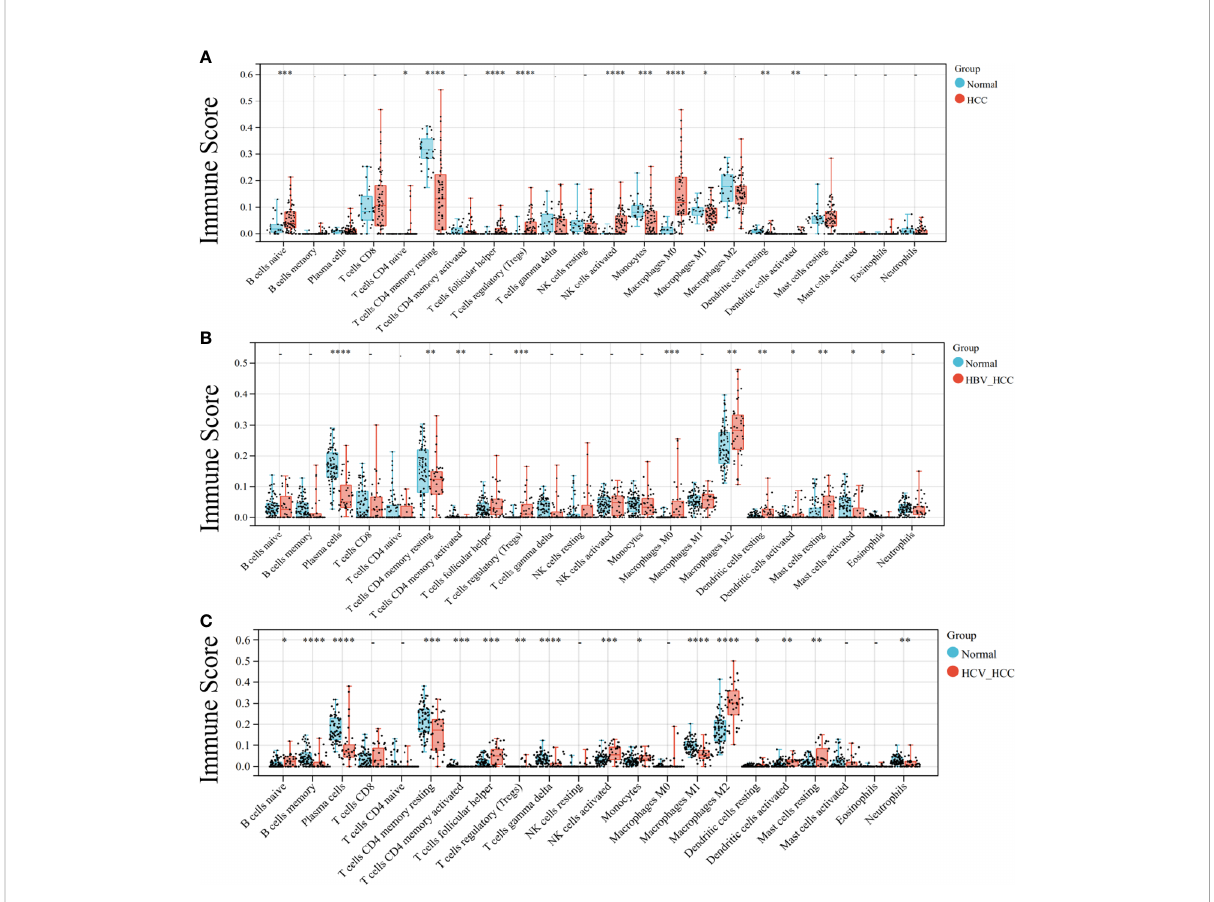
FIGURE 2 Analysis of immune in fi ltration in HCC. Immune in fi ltration of HCC (A) , HBC-HCC (B) , and HCV-HCC (C) using CIBERSORT. Statistical signi fi cance is noted with asterisk: * < 0.05, ** < 0.01, *** <0.001, ****<